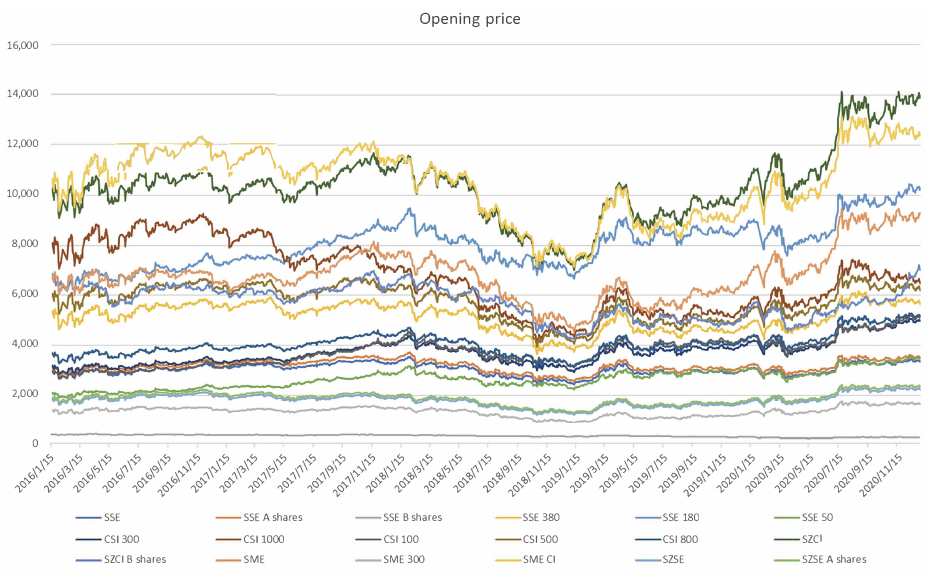
Figure A1. History of opening price in 18 Chinese stock